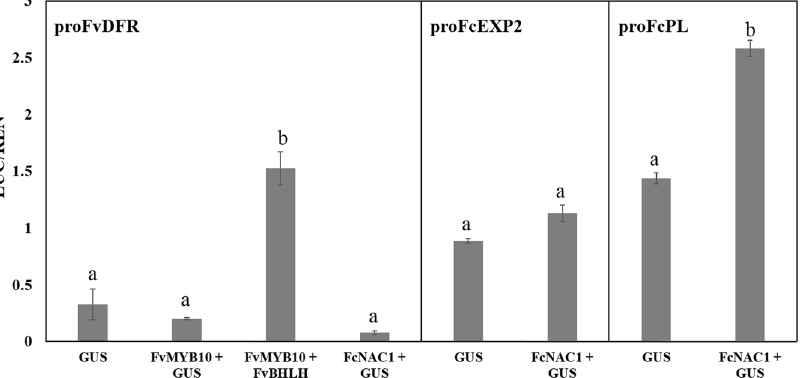
Figure 6. Functional assay of FcNAC1 gene by transient transformation of tobacco leaves. The ratio of LUC/ REN activities obtained after Dual Luciferase interaction assay of FcNAC1 with the promoter sequences of FvDFR (Dihydroflavonol reductase, 1560 bp) (XP_004308377), FcEXP2 (Expansin 2, GenBank KC527027, 847 bp) and FcPL (Pectate lyase, GenBank KC527025, 1038 bp) in transiently transfected N . benthamiana leaves are shown. GUS represents the plasmid 35SPro- GUS (negative control). FvMYB10 (GenBank EU155163.1) and FvBHLH (Basic helix loop helix XP_004308377; 1932 bp) were used as positive controls of the technique. Bars represent the bioluminescent measure of 4 replicates ± standard deviation. Different letters indicate statistical differences ( p ≤ 0.05) compared to respective GUS